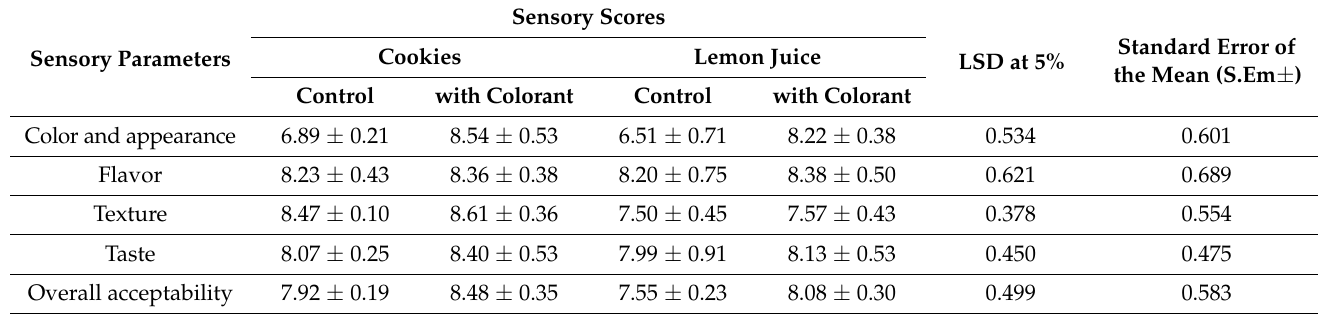
Table 1. Sensory evaluation of the fungal colorant-supplemented food